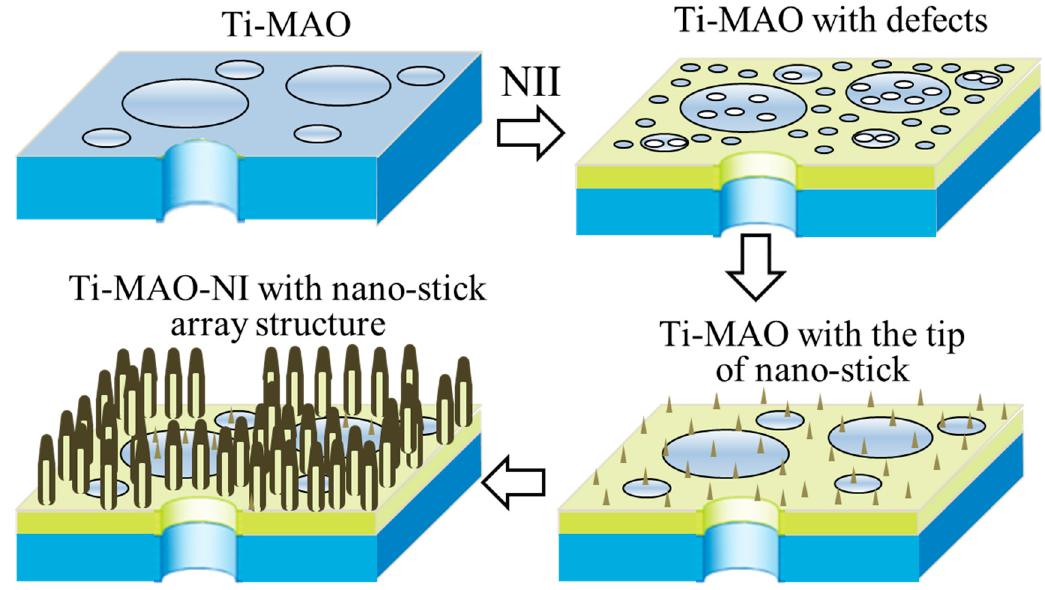
Figure 5. Schematic diagram of the growth mechanism of the TiO x /TiN x composite modification layer with a nanostitch array structure during NII.